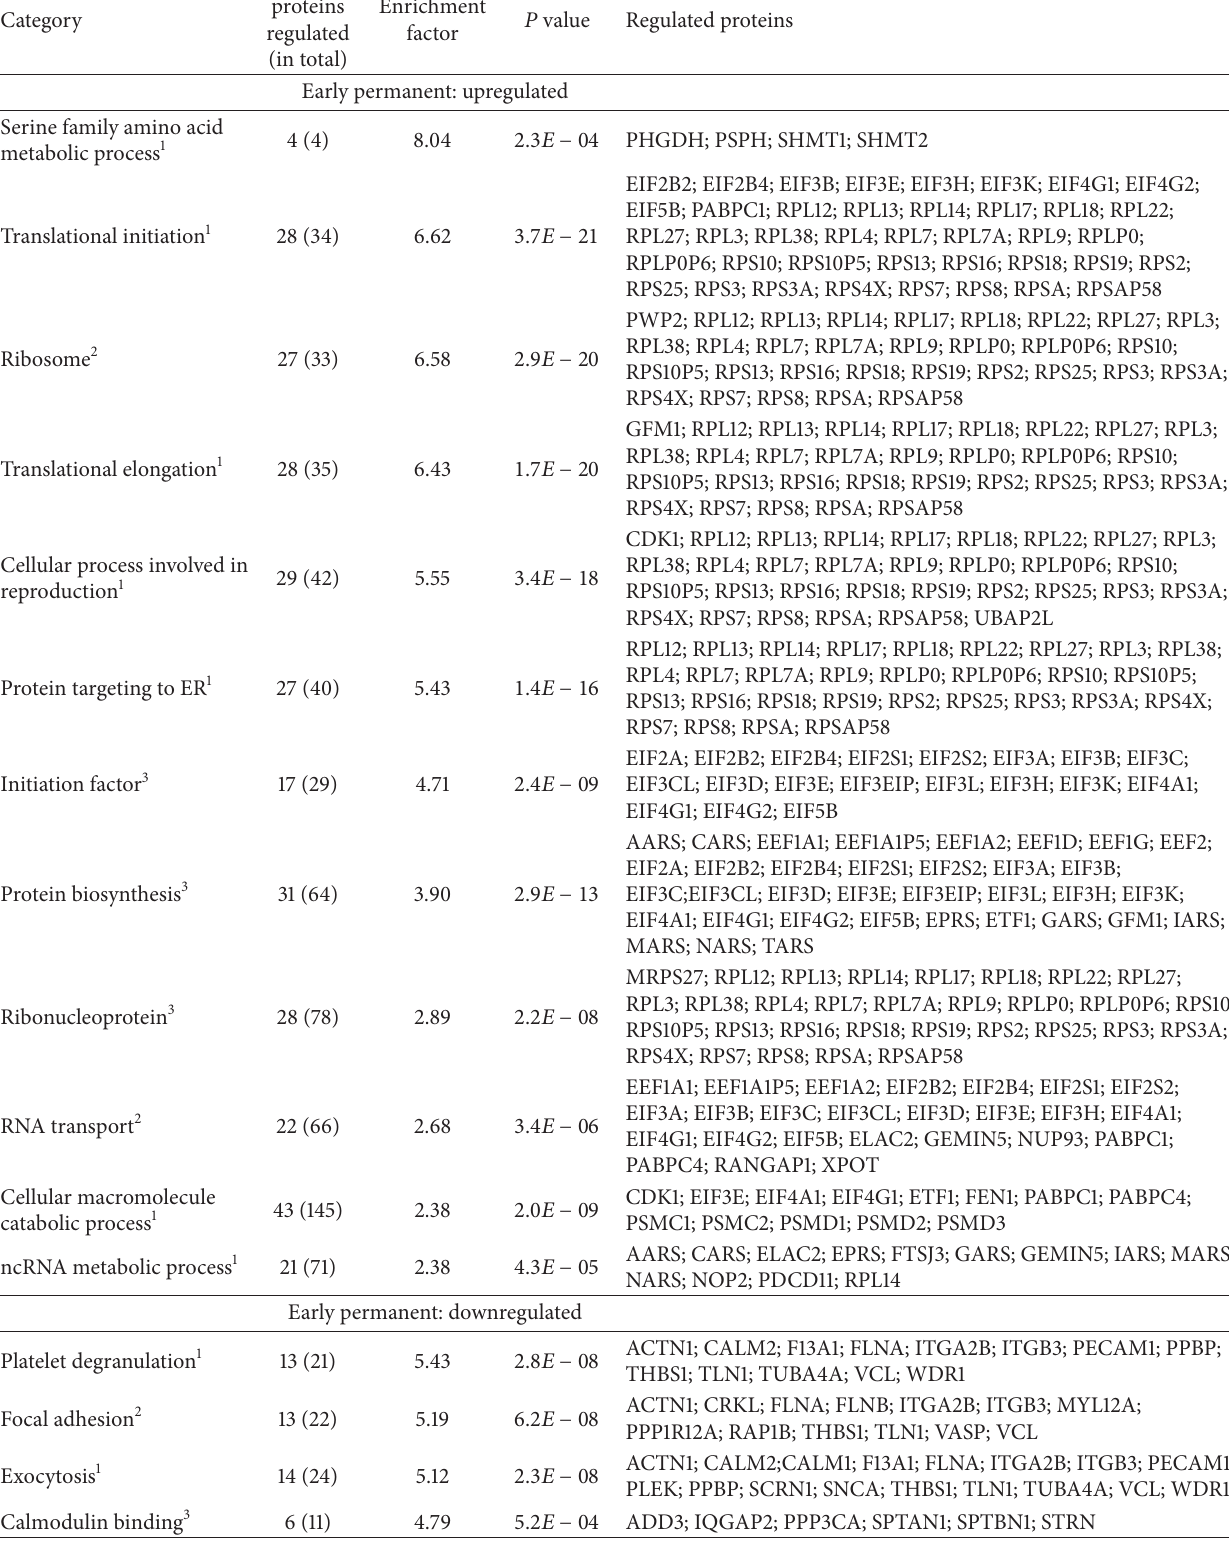
Table 2: Examples of enriched biological processes in significant regulated